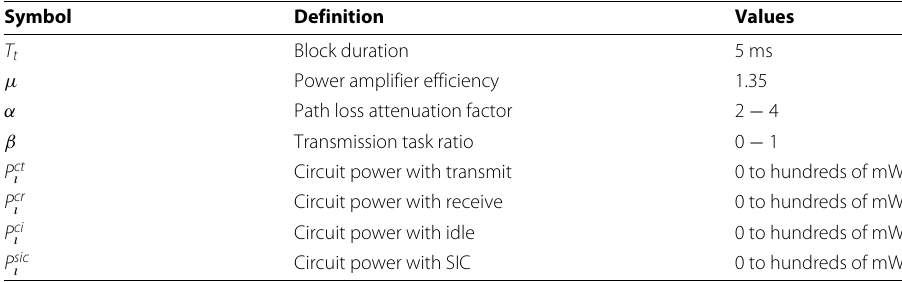
Table 2 Simulation